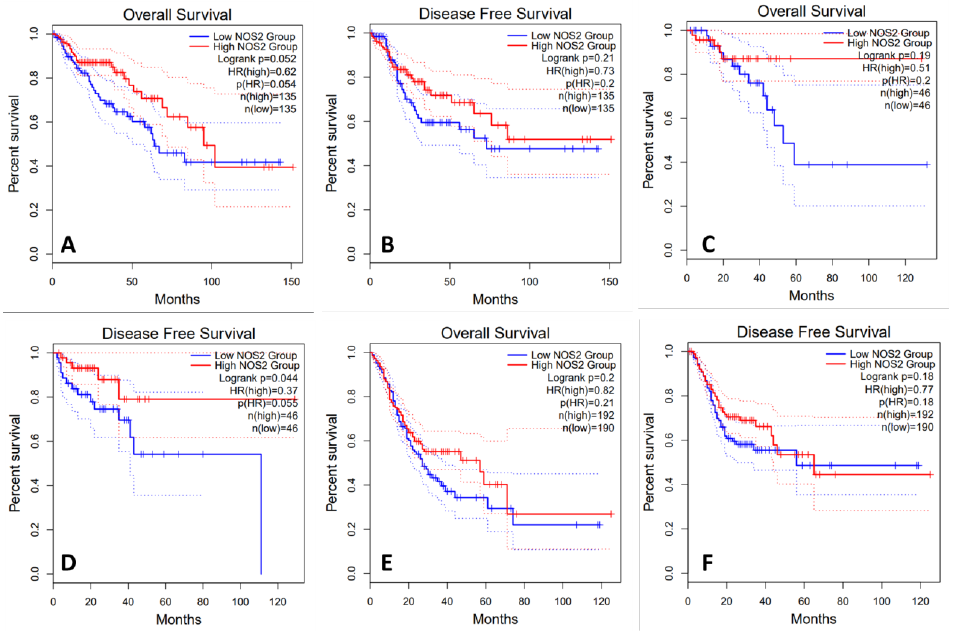
Figure 8: Survival curve between iNOS/NOS2 high and low expression groups (A:OS in colon cancer; B: DFS in colon cancer; C: OS in rectal cancer; D: DFS in rectal cancer; E: OS in gastric cancer; F: DFS in gastric